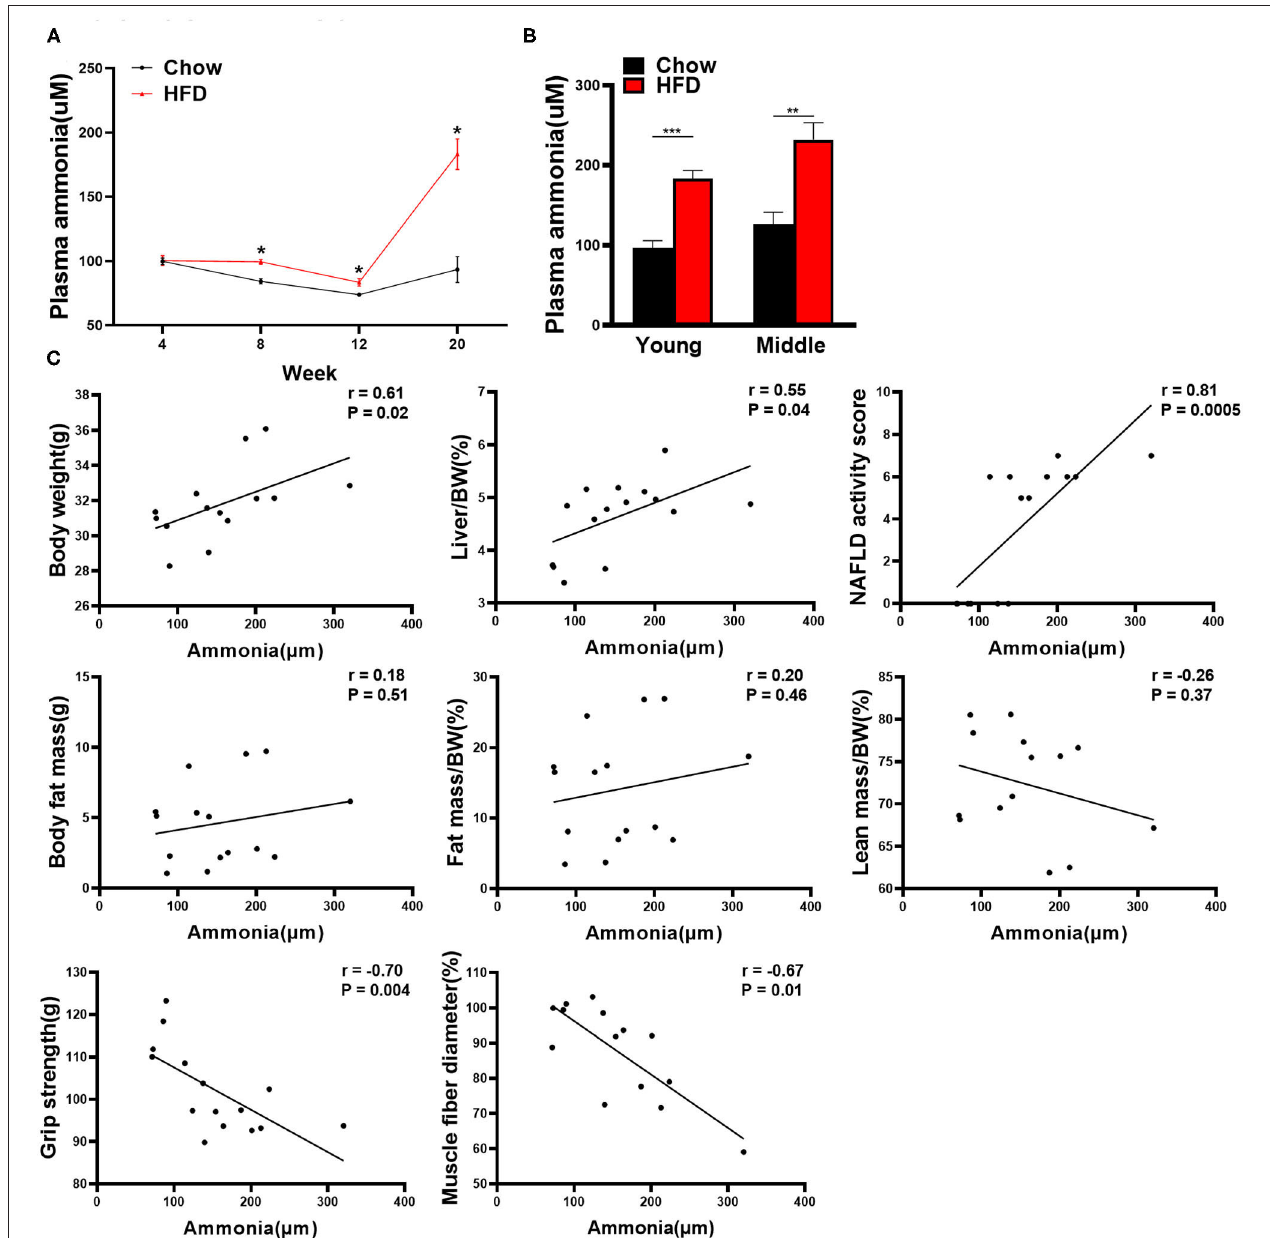
FIGURE 5 | Correlation analysis between plasma ammonia level and other indexes in mice. (A) Plasma ammonia levels of young mice over the course of the experiment ( n = 5–9). (B) The plasma ammonia level of young mice and middle-aged mice at the end of the 20th week is detected ( n = 5–9). (C) Correlation between plasma ammonia level and other indexes in young mice including body weight, liver index, NAS score, fat mass, fat mass/bodyweight (BW), lean mass/BW, grip strength, and muscle fiber diameter (Spearman correlation analysis, n = 14–15). The data are presented as the mean ± SEM, unpaired two-tailed Student’s t -test. * P < 0.05, ** P < 0.01, *** P <